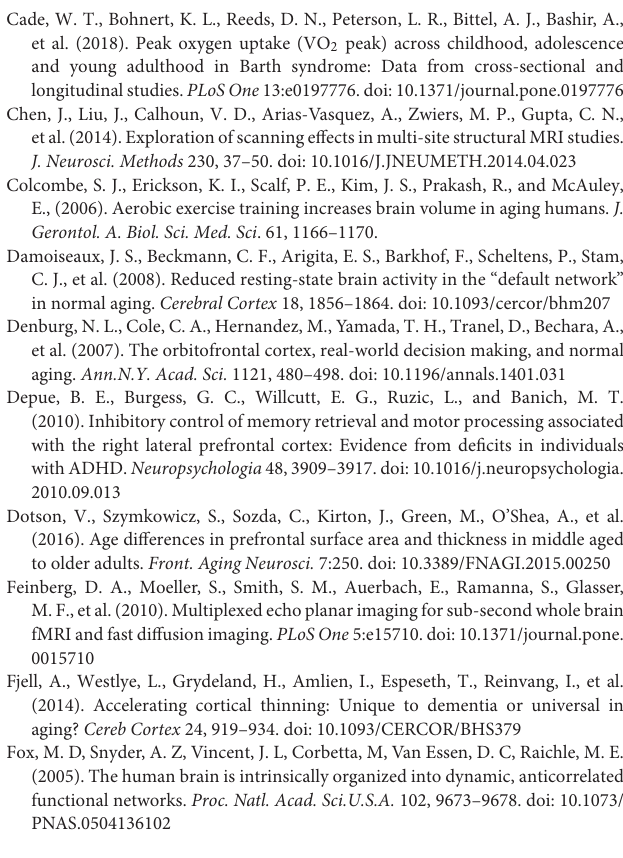
Supplementary Figure 8 | Transverse image displaying functional connections between ROIs within the DMN that were significantly different in terms of strength between young and older adults and passed correction for false discovery rate; blue connections indicate stronger functional connectivity among young adults, while red connections indicate stronger functional connectivity among older adults. Supplementary Figure 9 | Coronal image displaying functional connections between ROIs within the DMN that were significantly different in terms of strength between young and older adults and passed correction for false discovery rate; blue connections indicate stronger functional connectivity among young adults, while red connections indicate stronger functional connectivity among older adults. Supplementary Figure 10 | Sagittal image displaying functional connections between ROIs within the DMN that were significantly different in terms of strength between young and older adults when controlling for VO 2 peak and passed correction for false discovery rate; blue connections indicate stronger functional connectivity among young adults, while red connections indicate stronger functional connectivity among older adults. Supplementary Figure 11 | Transverse image displaying functional connections between ROIs within the DMN that were significantly different in terms of strength between young and older adults when controlling for VO 2 peak and passed correction for false discovery rate; blue connections indicate stronger functional connectivity among young adults, while red connections indicate stronger functional connectivity among older adults. Supplementary Figure 12 | Coronal image displaying functional connections between ROIs within the DMN that were significantly different in terms of strength between young and older adults when controlling for VO 2 peak and passed correction for false discovery rate; blue connections indicate stronger functional connectivity among young adults, while red connections indicate stronger functional connectivity among older